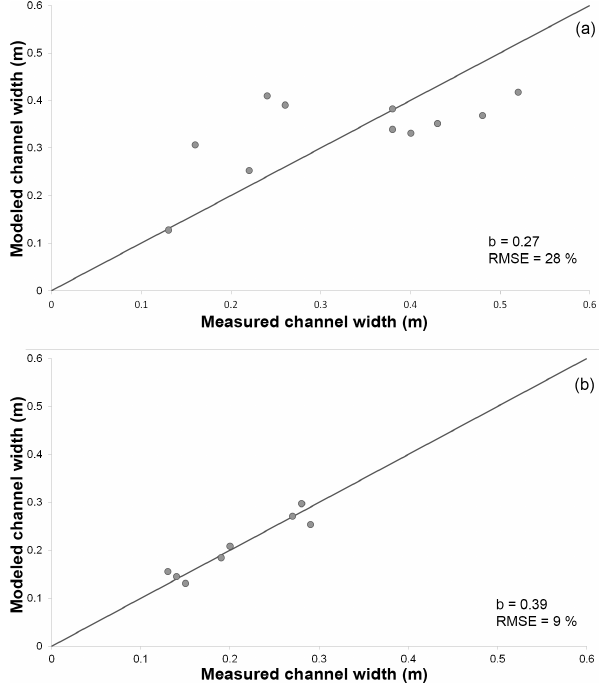
Figure 7. Channel width can be modeled using the hydraulic ge- ometry relationship (Eq. 1). In both plots the solid black line is a 1:1 line. (a) The relationship measured in the channels formed in the fine-grained substrate has a constant b value that is less than the values commonly observed in nature. (b) The relationship mea- sured in the channels formed in the sand substrate has a constant b value of 0.4, which is in the intermediate range of the commonly proposed